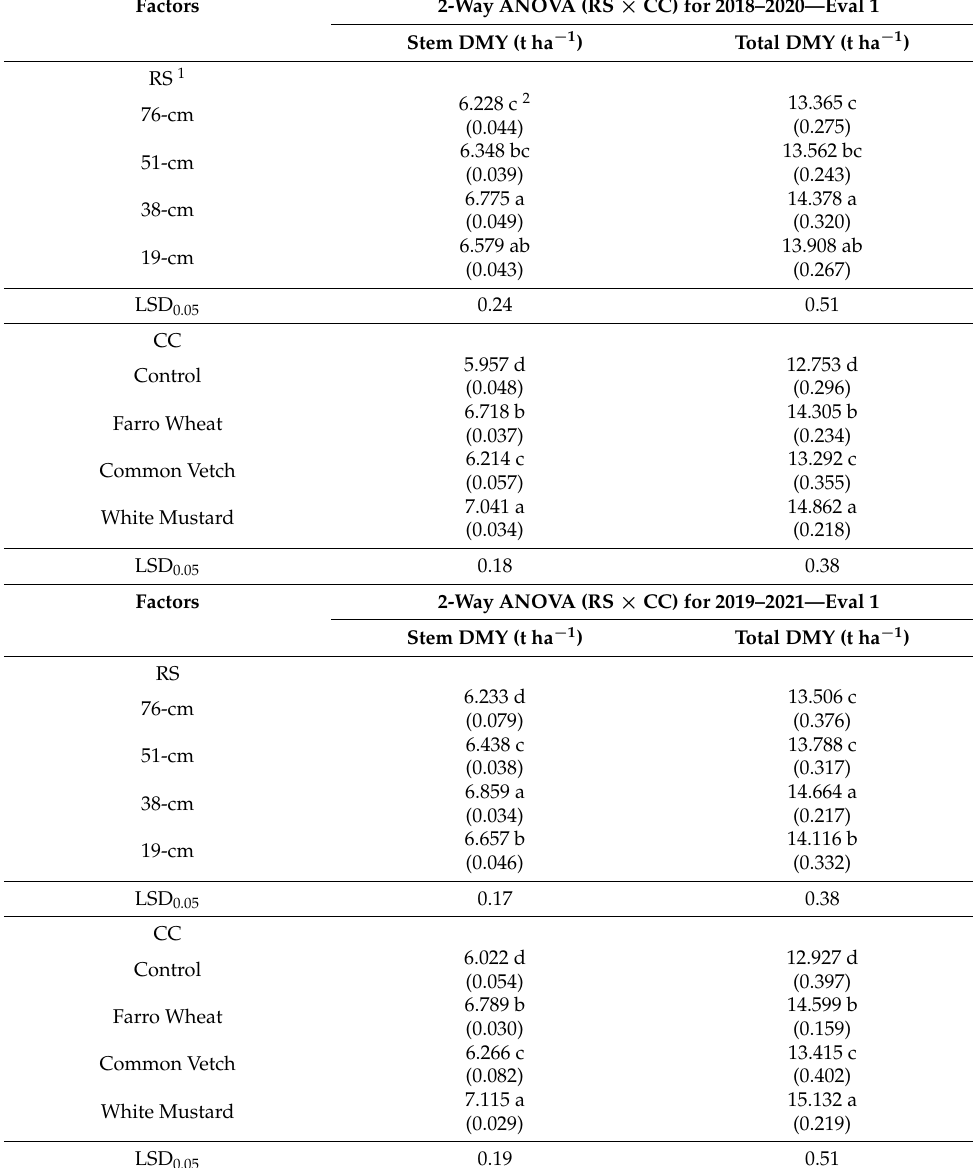
Table 9. The effects of sulla row spacing and cover crops on sulla cumulative two-year stem DMY (t ha − 1 ) and total DMY (t ha − 1 ) in the 2018–2020 and 2019–2021 growing cycles. Data of Eval 1 were analyzed separately for each growing cycle. Data of Eval 2 were pooled over growing